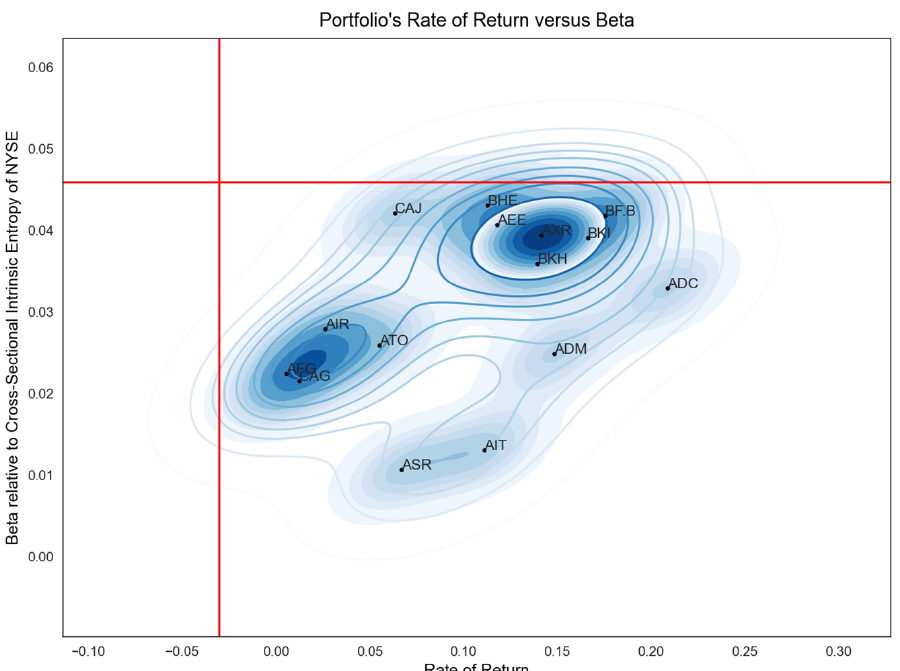
Figure A1. A set of 15 NYSE symbols that outperformed the DJIA index in terms of rate of return without being exposed to higher risk (125-day trading interval, from 1 March 2022 to 26 August 2022).